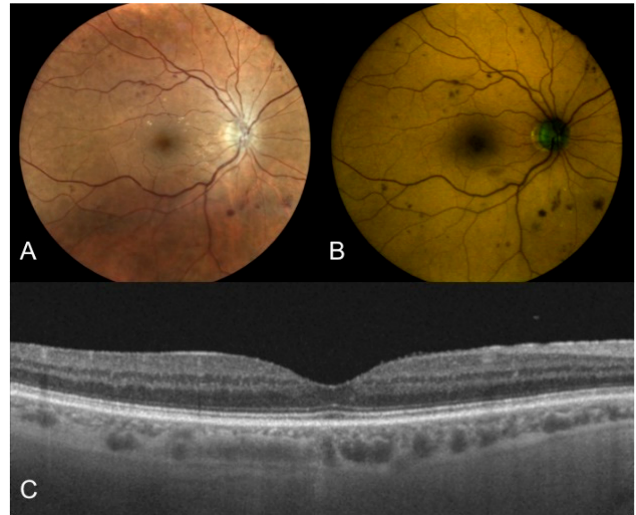
Figure 2. Right eye of a 68-year old male patient affected by type 2 DM with moderate DR. ( A ) True- color fundus photography of the posterior pole showing multiple hemorrhages and initial vitreo- retinal interface syndrome; ( B ) Color-FAF of the same eye with detected values of foveal GEFC and REFC intensity of 17 and 26, respectively; ( C ) OCT horizontal B-scan centred on the fovea showing a dry macula with normal reflectivity of the inner and outer retinal layers. DM: diabetes mellitus; DR: diabetic retinopathy; FAF: fundus autofluorescence; GEFC/REFC: green/red emission fluorescence components; OCT: optical coherence tomography.